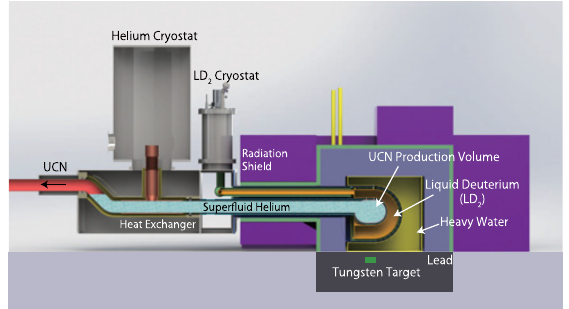
Figure 1. TUCAN source. Superfluid helium UCN converter surrounded by heavy water and liquid deuterium neutron moderators located above the spallation target. The superfluid helium is cooled by the helium cryostat.